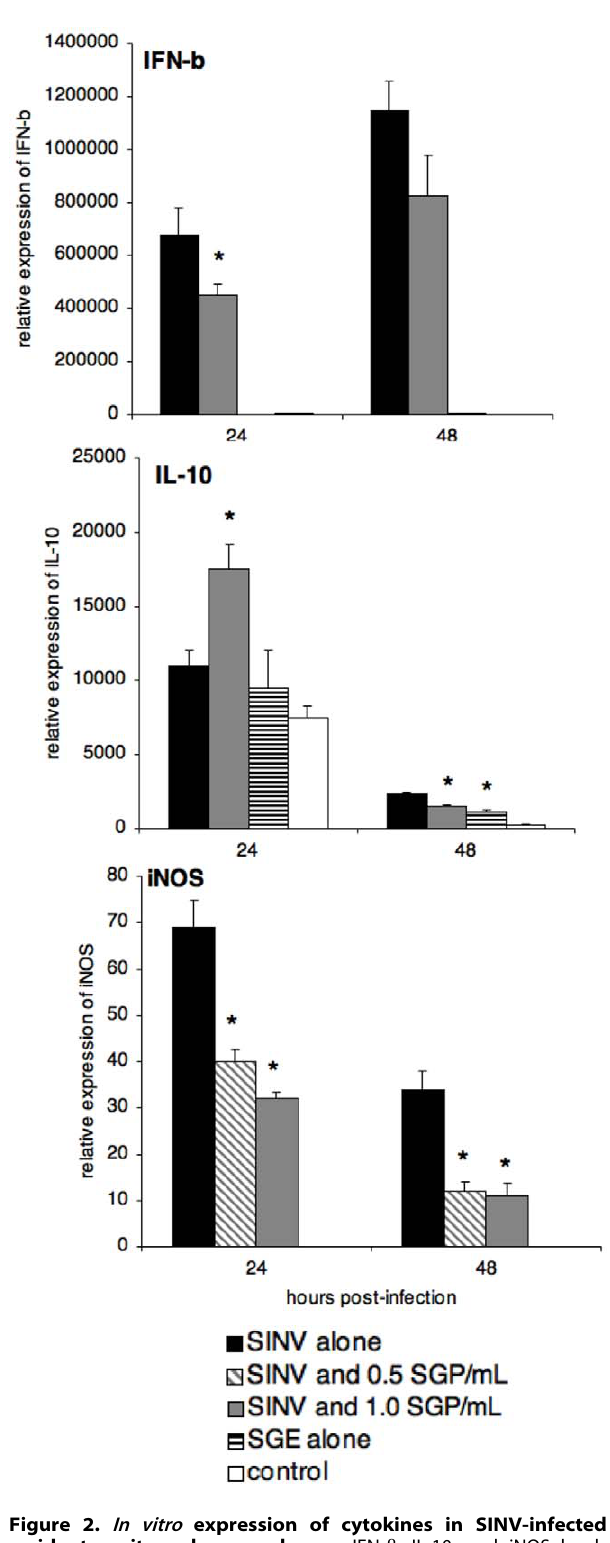
Figure 2. In vitro expression of cytokines in SINV-infected resident peritoneal macrophages. IFN- b , IL-10, and iNOS levels were assessed by real-time RT-PCR at 24 and 48 h post-infection (MOI =1). Their mRNA expression levels were normalized to those of the GAPDH gene. The means 6 standard deviation are shown, and an asterisk signifies a statistically significant difference (p , 0.05) as compared to the group infected with SINV alone as determined by Mann-Whitney test. IFN- c , IL-12, and IL-1 b mRNA expression, as well as